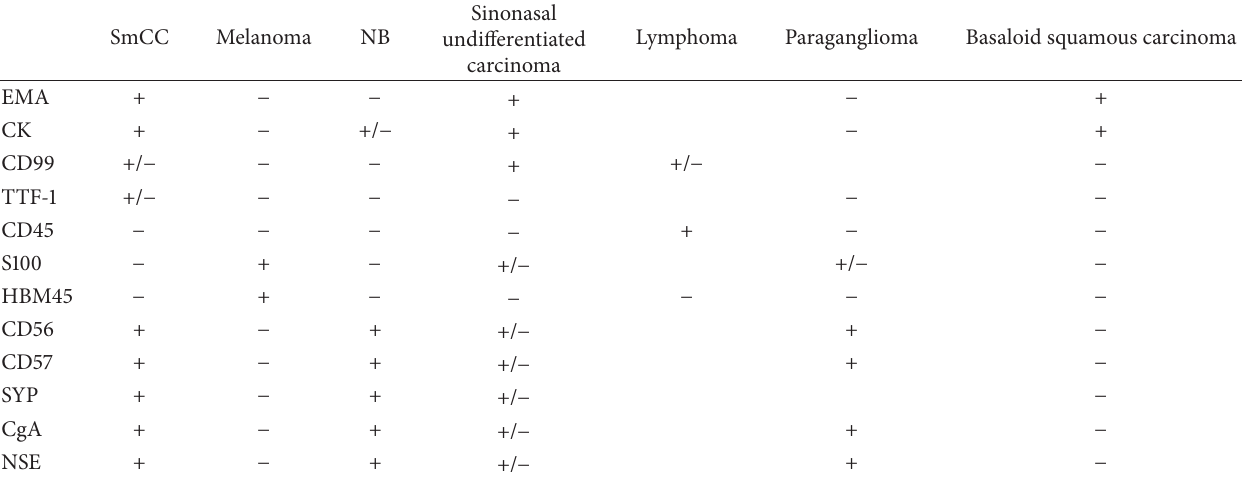
Table 2: Immunohistochemical staining of some malignant round cell tumors. SmCC: small cell carcinoma, NB: neuroblastoma, SYP: synaptophysin, CgA: chromogranin A, EMA: epithelial membrane antigen, CK: cytokeratin, TTF-1: thyroid transcription factor-1, NSE: neuron specific